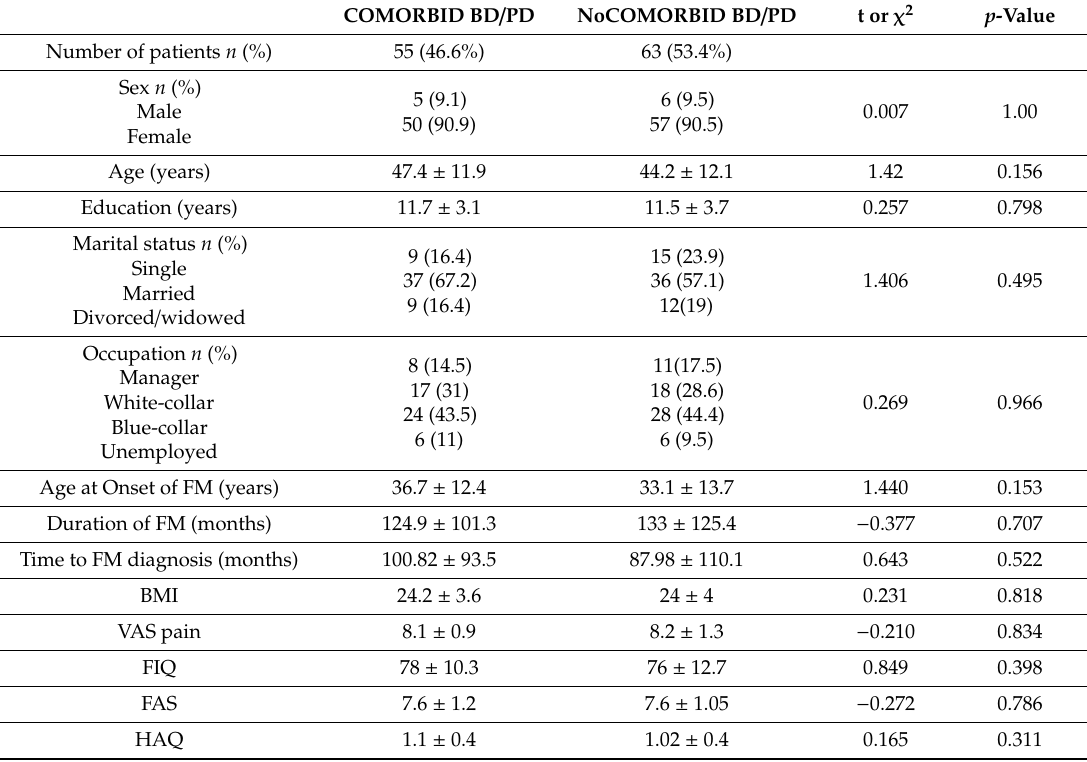
Table 4. Comparison between FM patients with and without comorbid threshold BD /